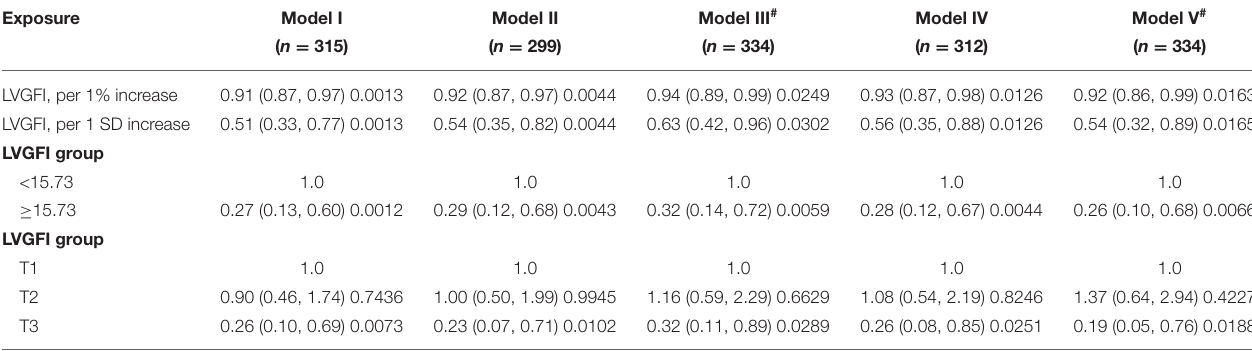
TABLE 3 | Multivariate Cox analysis with CMR- LVGFI for MACEs in patients with HF within the median follow-up period of 565 days. Exposure Model I Model II Model III # Model IV